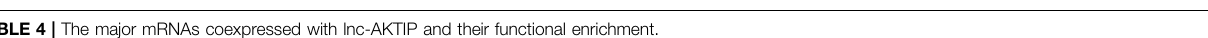
TABLE 4 | The major mRNAs coexpressed with lnc-AKTIP and their functional enrichment. mRNAs Gene